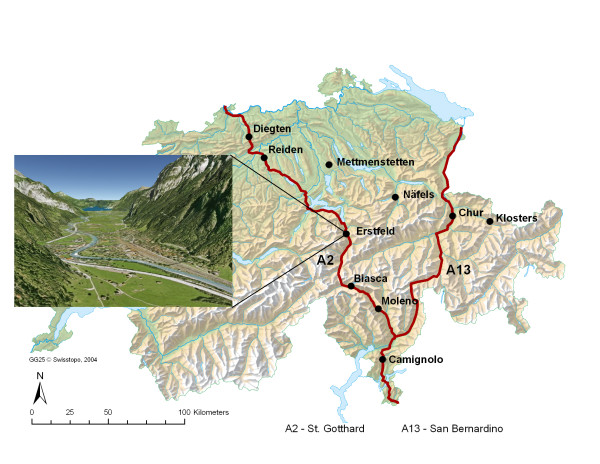
Study area. Map of Switzerland with the 10 study communities. The inset shows the topography in Erstfeld having a width of 800 m at the bottom of the valley.